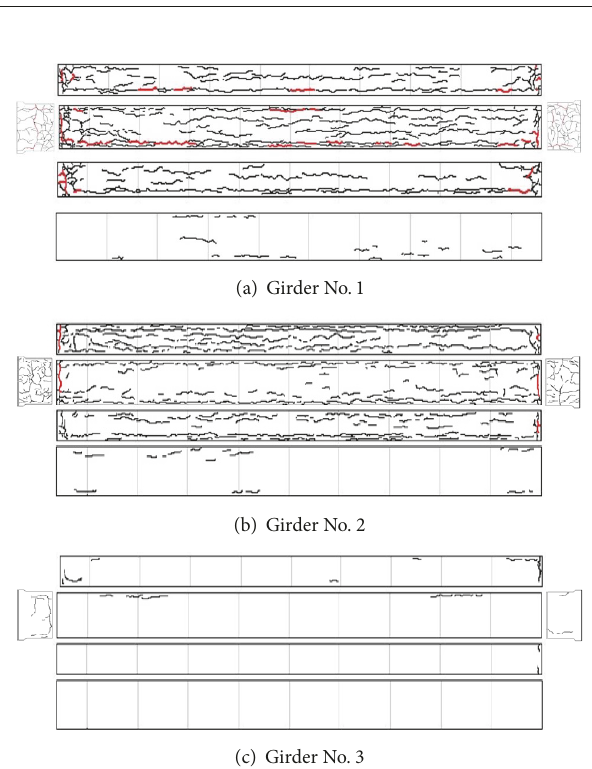
Figure 3: ((a)–(c)) Crack patterns of the girders (from top to bottom: north surface, top surface and both surfaces near both ends, south surface, and bottom